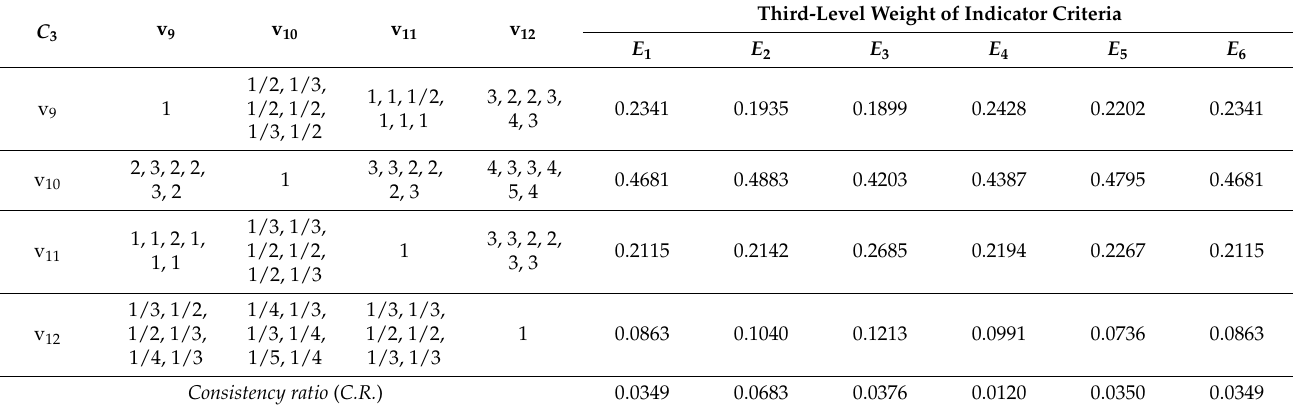
Table 12. Judgment of six experts’ scoring for the importance of legal value